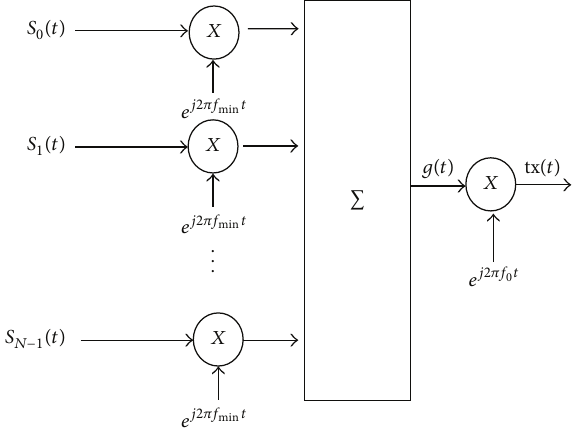
Figure 2: OFDM block